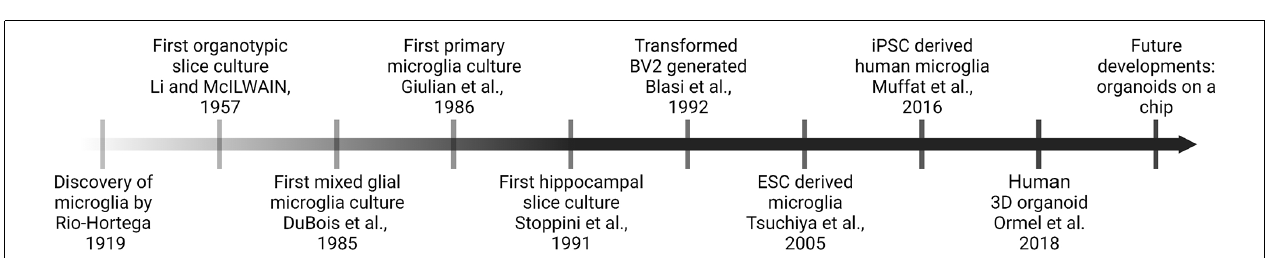
FIGURE 2 | Timeline of selected milestones in the development of microglia in vitro models over the last